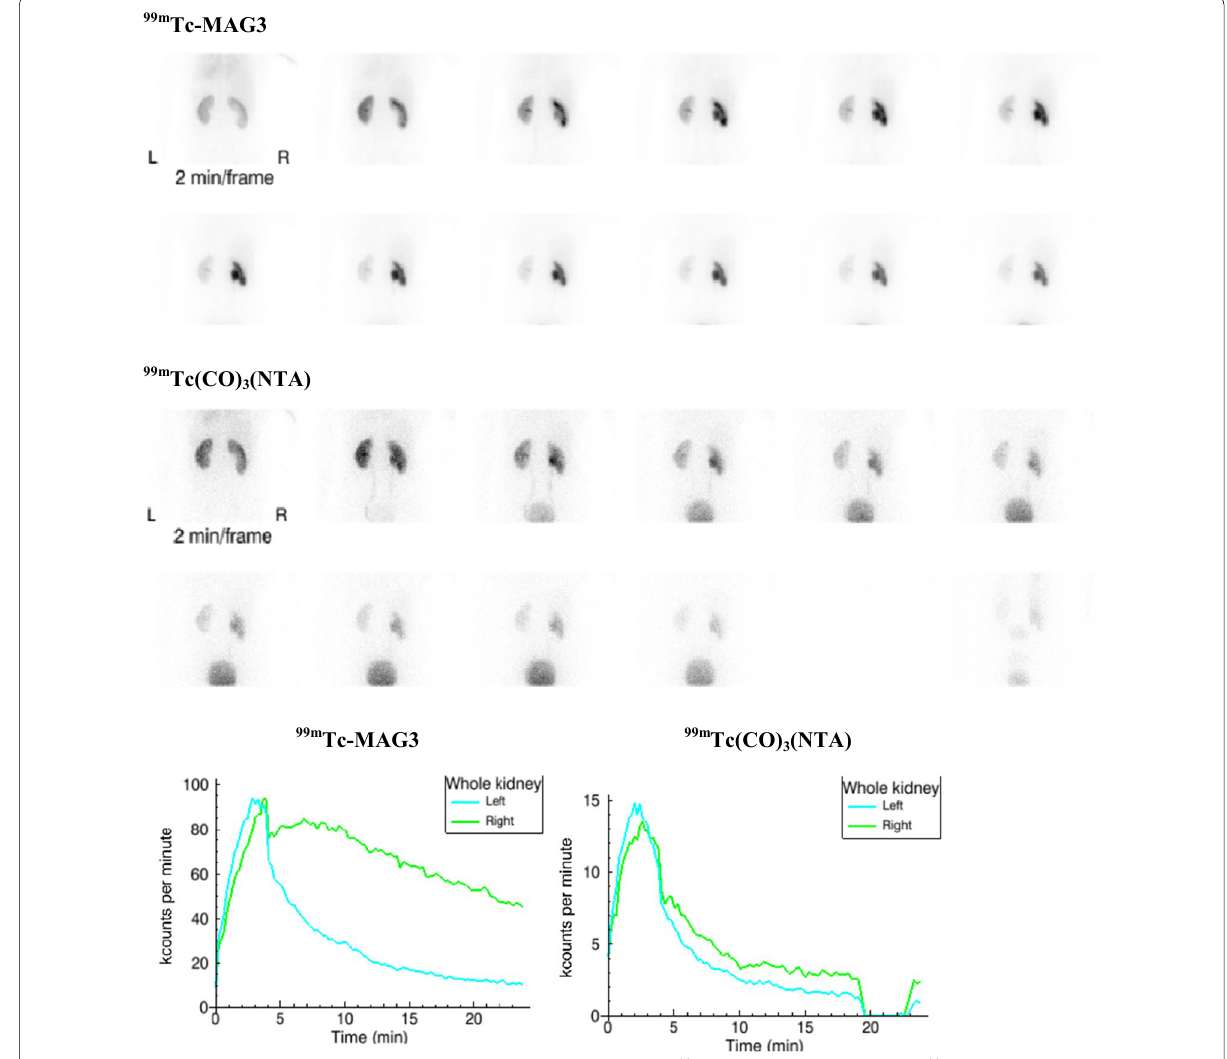
Fig. 3 Subject 1: Two minute sequential images following the administration of [ 99m Tc]Tc-MAG3 (338 MBq) and [ 99m Tc]Tc(CO) 3 (NTA) (45 MBq) with the corresponding renogram curves. The subject receiving NTA had to get off the table to void at 20 min and was repositioned for the final frame. The relative uptake of the left kidney was 52% for NTA and 53% for MAG3. The T1/2 for 99m Tc-MAG3 was 17.6 min compared to 4.0 min for NTA. Because of the images, renogram curve and prolonged T1/2, the right kidney of the MAG3 acquisition might be interpreted as being indeterminate or representing an obstructed kidney whereas the NTA acquisition demonstrates that the right kidney is not